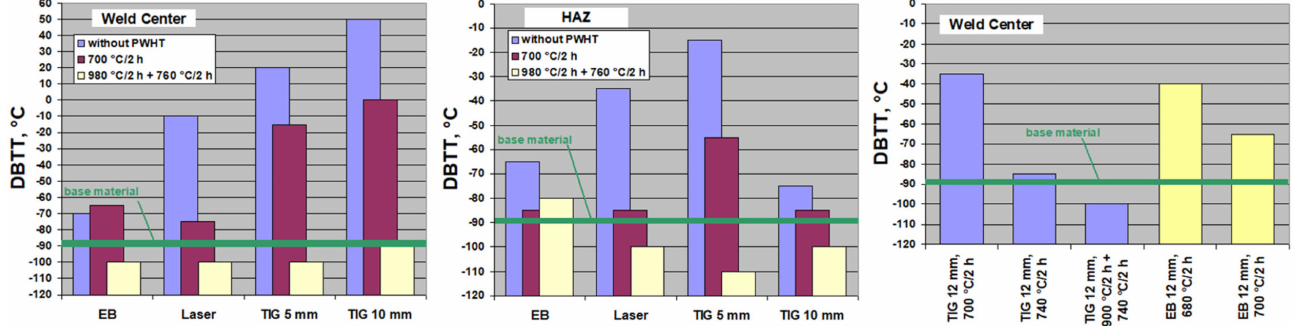
Figure 17. Ductile-to-brittle transition temperature (DBTT) of 5 mm, 10 mm, and 12 mm welds after different post-welding heat treatments. The notches of the Charpy specimens were fabricated either in the weld center or in the HAZ (as indicated). For comparison, the DBTT of the base material is plotted as a horizontal